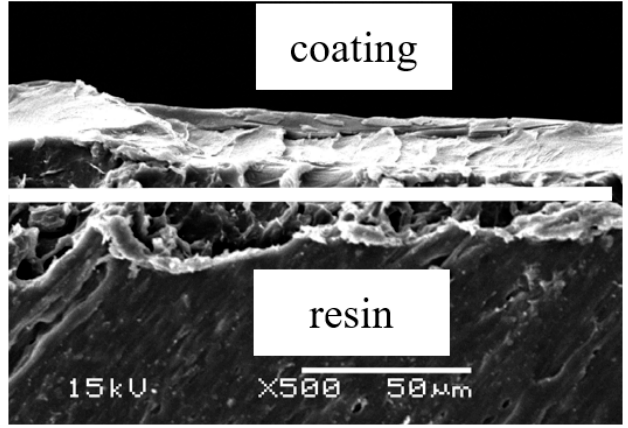
Figure 3. Scanning electron microscopy of cross sectional photographs of the TiO 2 coating.